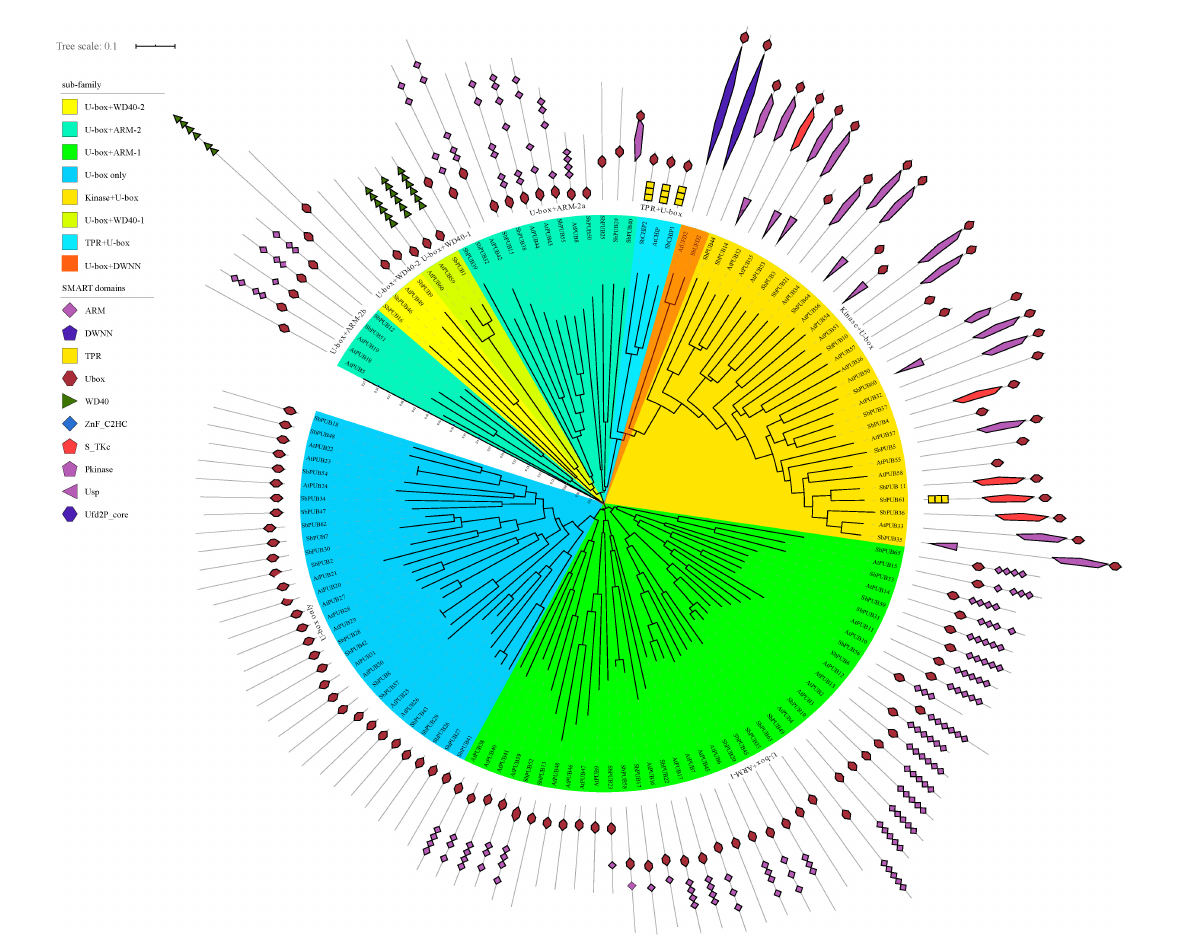
FIGURE1 Phylogenetic tree and domain analysis of U-box genes in Sorghum and Arabidopsis . Phylogenetic relationships between U-box genes in Sorghum bicolor and Arabidopsis thaliana were explored. Rootless trees were generated by the neighbor-joining (NJ) method using MEGA7 software. Numbers next to branches indicate 1,000 bootstrap replicates as a percentage. The phylogenetic classification of U-box genes is marked with corresponding colors and different shapes. Colors in the outer ring represent different domains, as shown in the color legend in the upper left corner. U-box, Ub fusion degradation 2 (UFD2) domain; PUB, plant U-box; UFD, Ub fusion degradation; CHIP, carboxyl terminus of heat shock protein 70-interacting protein; At, Arabidopsis thaliana ; Sb, Sorghum bicolor